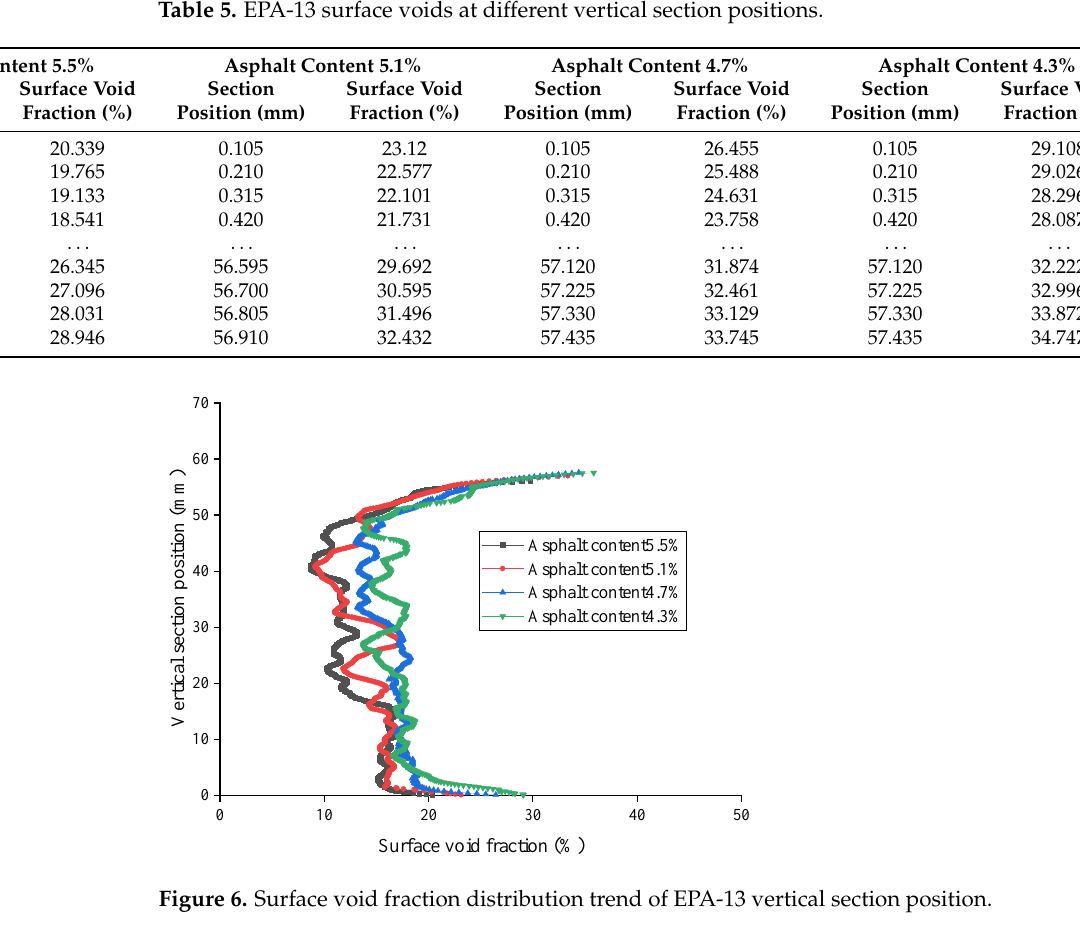
Table 6. EPA-13 surface voids at different radial section positions.